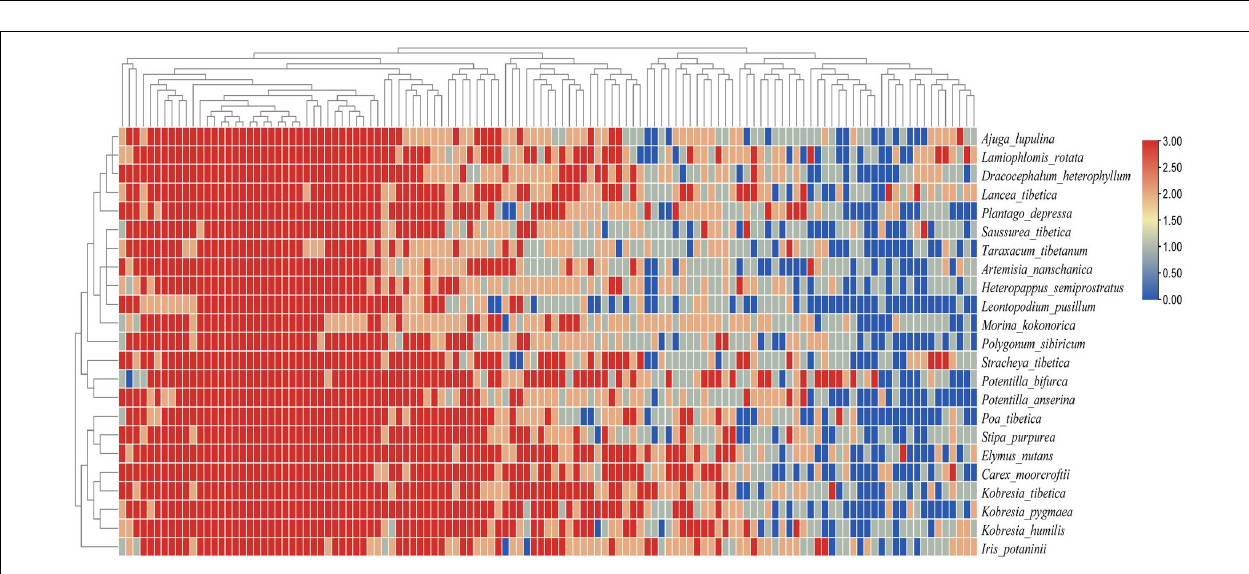
FIGURE 6 | Heat map of plant-AMF association frequency matrix combined with the phylogenetic tree. Different shades of color denote the association frequency between different plant species and AMF OTUs, and blue denotes an absence of